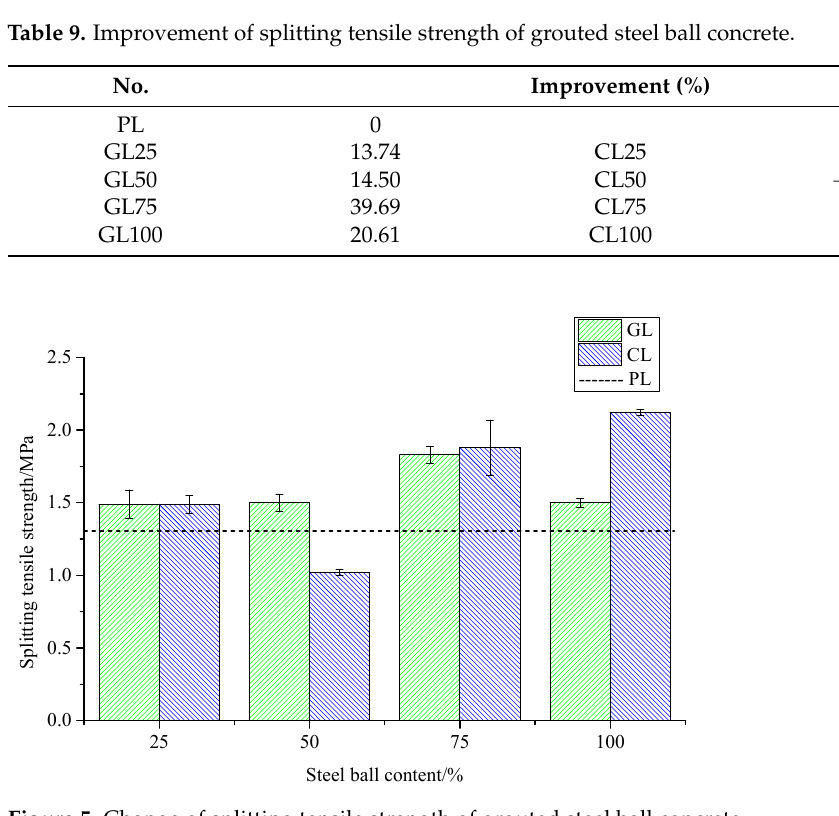
Figure 5. Change of splitting tensile strength of grouted steel ball concrete.